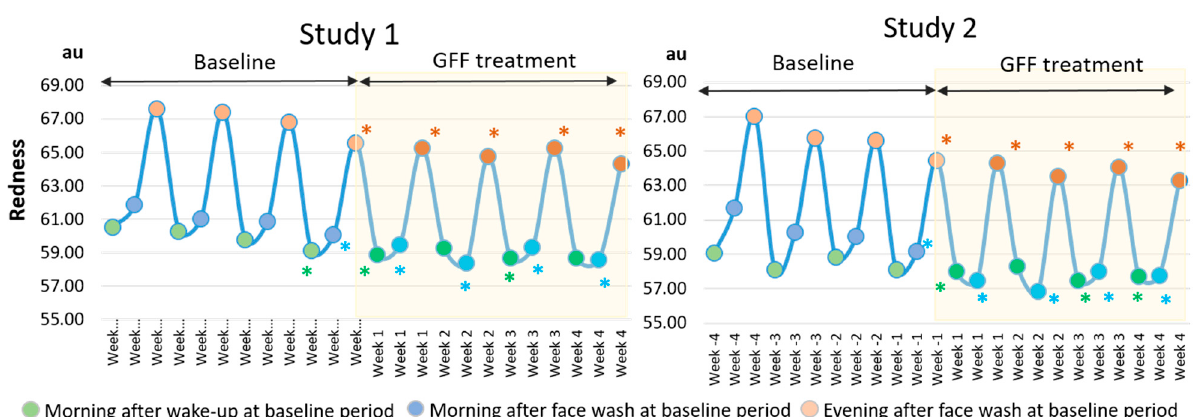
Figure 11. GFF treatment alleviates daily fluctuation of redness. The “evening after face wash” ‐ largest fluctuation of redness is shown at baseline period through week ‐ 4 to week ‐ 1. GFF treatment significantly improves the fluctuation of redness during week 1 to week 4. *: p < 0.05 compared with “morning after wake ‐ up” at week ‐ 4”. *: p < 0.05 compared with “morning after face wash” at week ‐ 4”. *: p < 0.05 compared with “evening after face wash” at week ‐ 4”.